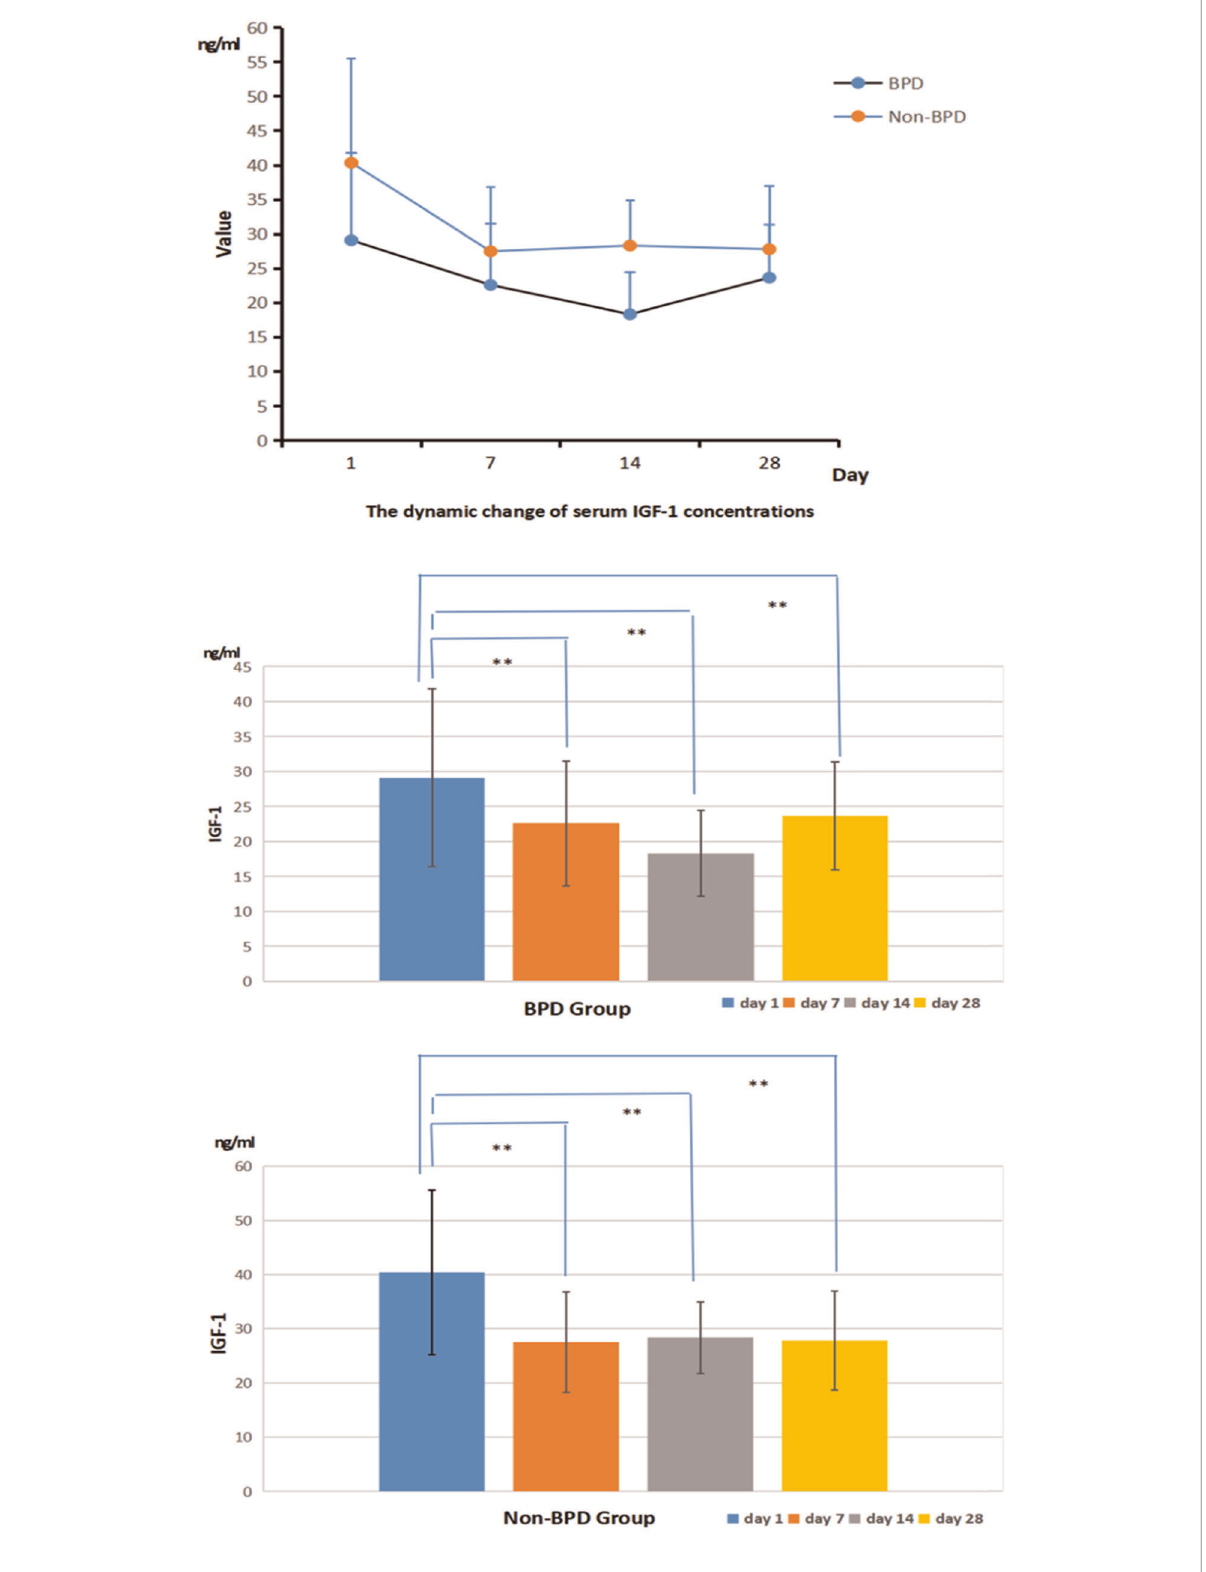
FIGURE 2 The dynamic serum IGF-1 concentrations in the BPD and the non-BPD group